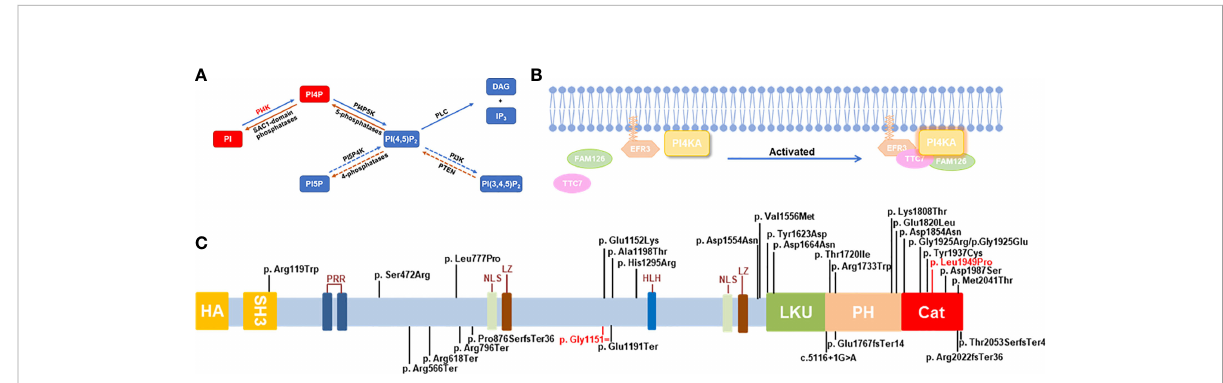
FIGURE 1 Schematic diagram for the role and mutations of PI4KA . (A) The pathway of phosphoinositide synthesis and degradation. Dashed arrows: in mammals only, phosphatidylinositol (PI), phosphatidylinositol-4-kinase (PI4K), messengers-diacylglycerol (DAG), inositol-1,4,5-triphosphate (IP3). (B) Schematic diagram of PI4KA interaction. (C) Schematic diagram of PI4KA domains and landscape of pathogenic variants. The putative PI4KA contains Src homology domain 3 (SH3; 81-132aa), proline-rich regions (PRR; 240-244aa and 266-276aa), nuclear localization signal (NLS; 980- 984aa and 1473-1489aa), leucine zipper (LZ; 993-1021aa), helix – loop – helix (HLH; 1351-1364aa), lipid kinase unique domain (LKU; 1621-1689aa), Pleckstrin homology domain (PH; 1718-1851aa), and catalytic domain (Cat; 1848-2103aa). The 30 pathogenic variants of PI4KA reported are shown over the diagram, and the variant identi fi ed in this study is in